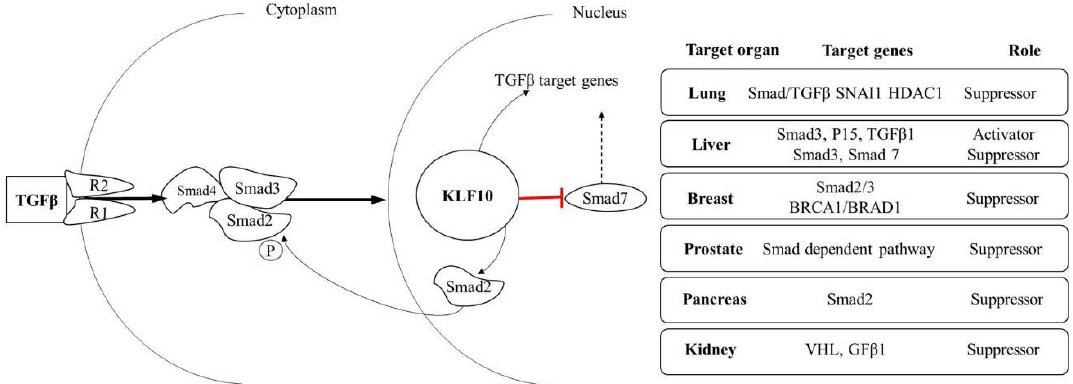
↑ increase; ↓ decrease.